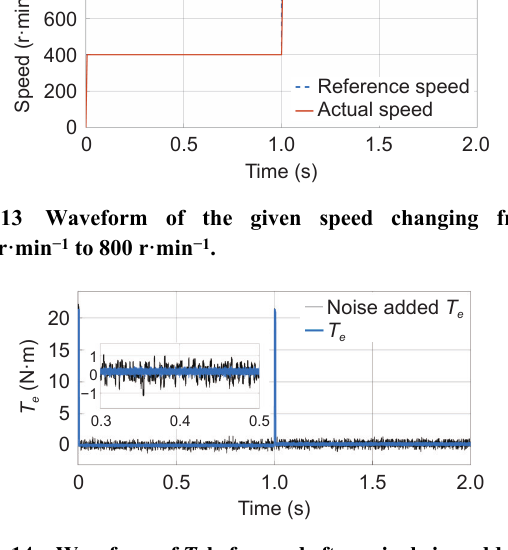
Fig. 14 Waveform of T